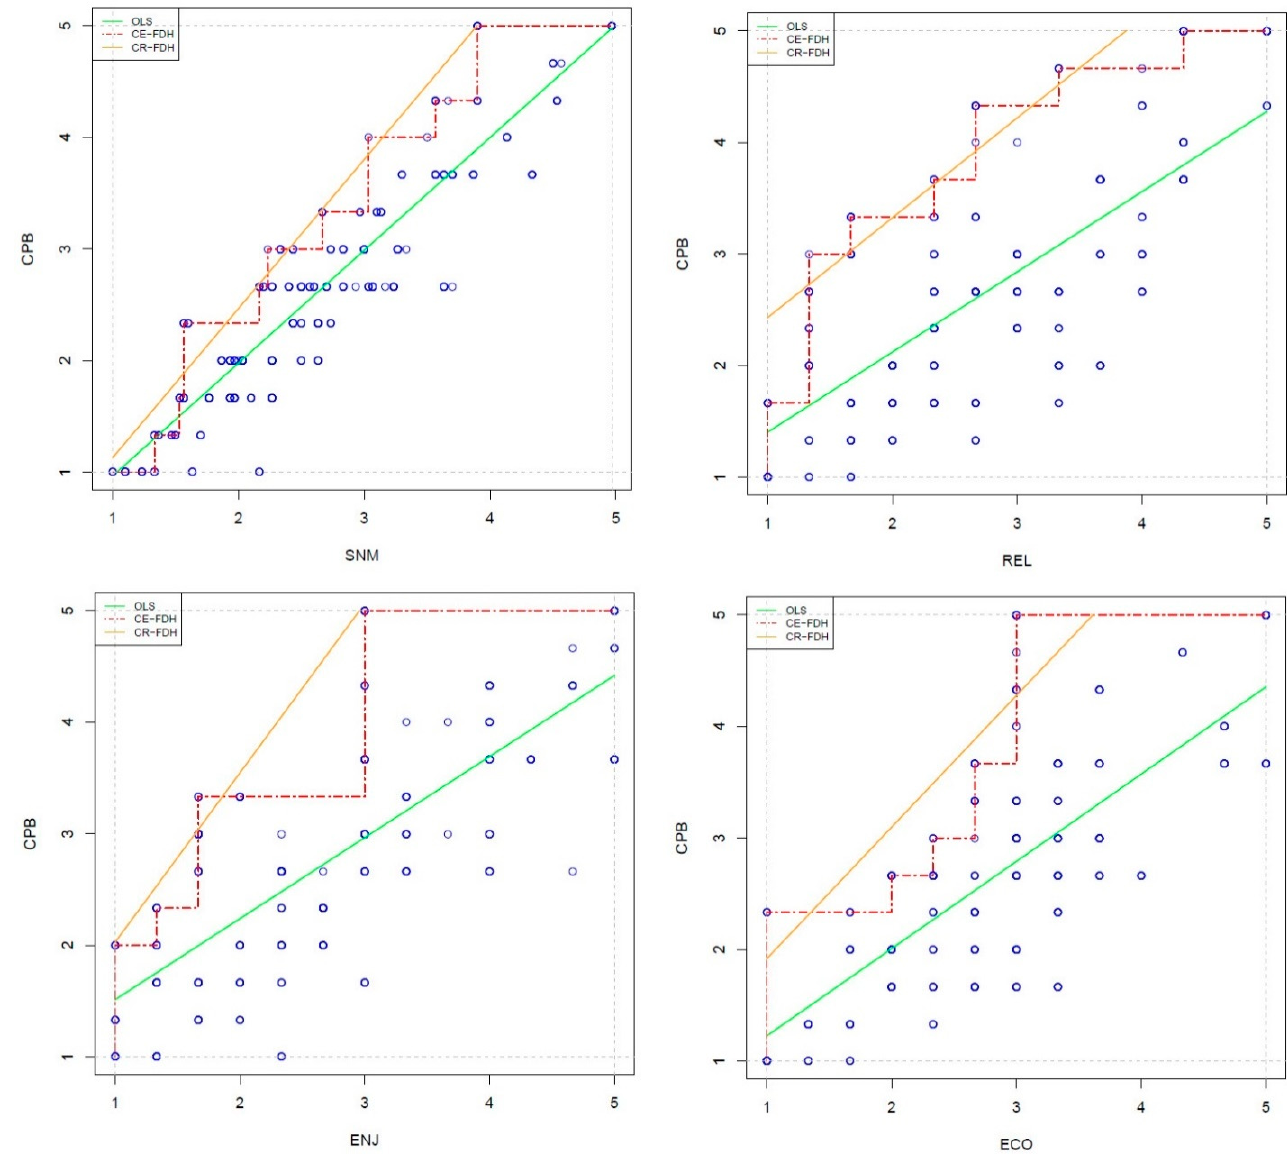
Figure 2. Scatter plots of NCA.